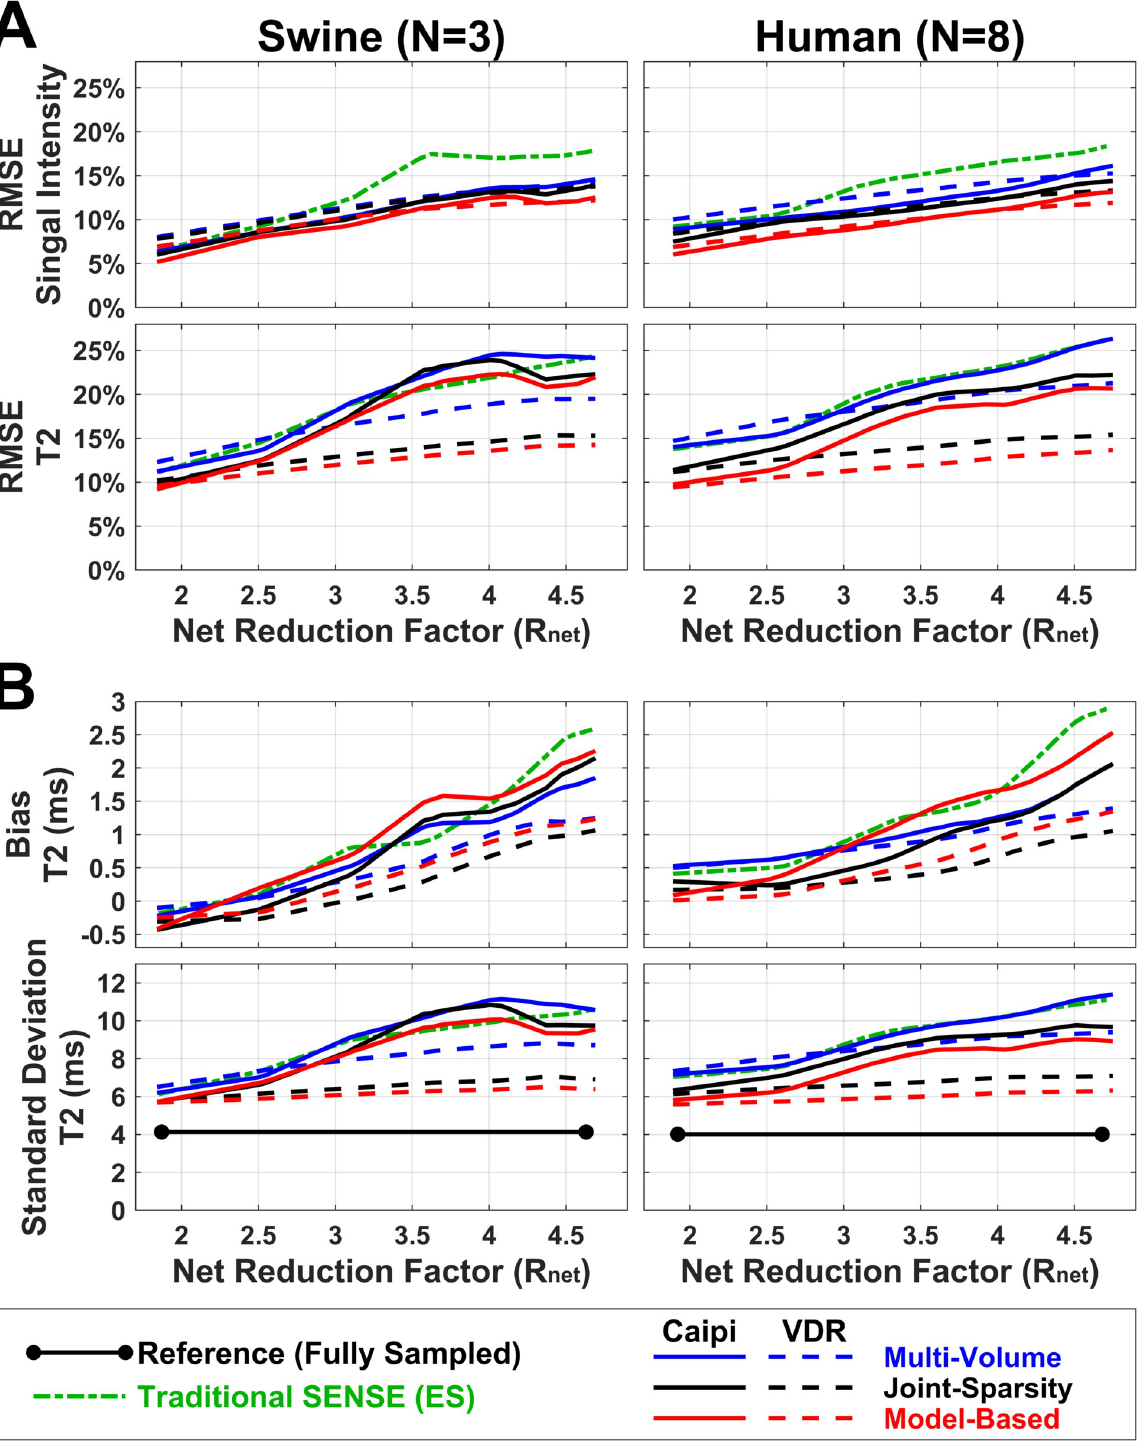
Fig 7. Average effects of the different reconstruction approaches on 4 metrics. Average effects of undersampling and reconstruction approaches on RMSE of both image data and T2 (A), and directly on accuracy (bias) and precision (SD) of T2 ( B ) in response to increases in acceleration rate. The bias in T2 represents the difference of mean T2 from the reference mean T2. The results in na ï ve animals (left) and normal human subjects (right) follow very similar patterns. The VDR undersampling pattern outperforms the Caipi pattern as acceleration factors